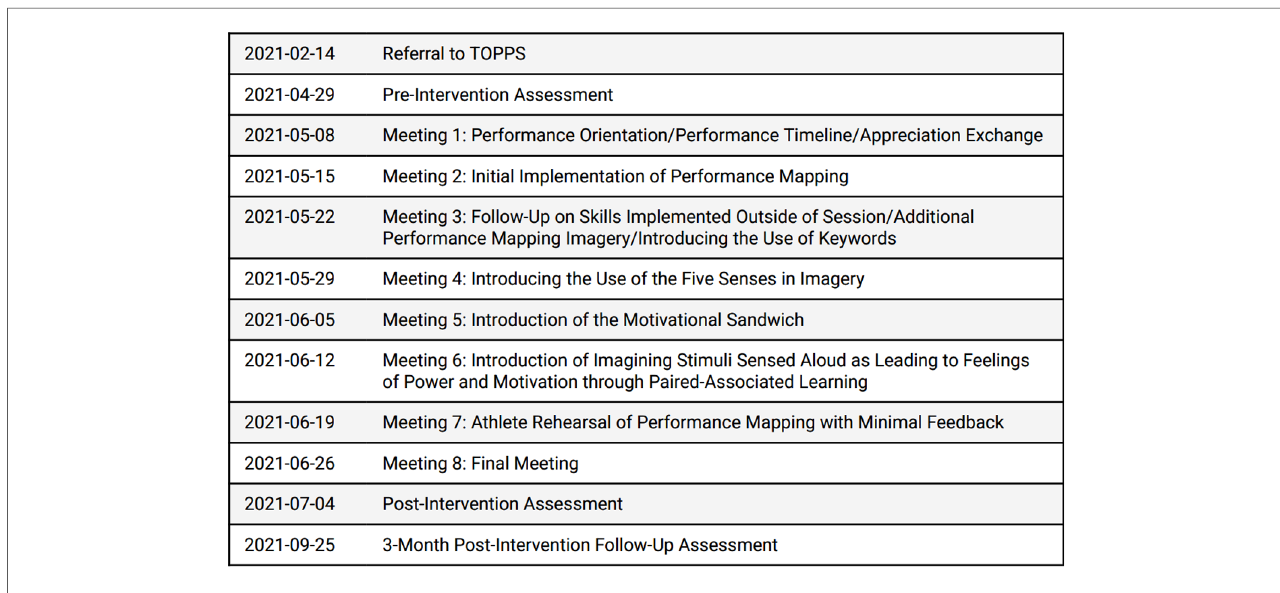
FIGURE 1 Treatment